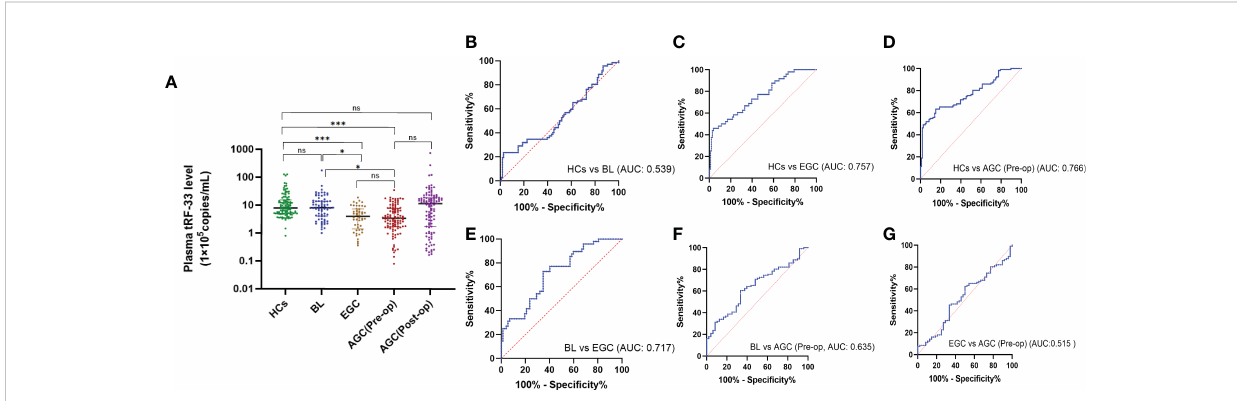
FIGURE 2 Expression levels and diagnostic values of tRF-33-P4R8YP9LON4VDP in different cohorts. (A) The amount of tRF-33 in the plasma showed a gradient change in healthy individuals (HC, n = 106), benign lesion (BL, n = 72), early gastric cancer (EGC, n = 48), pre-operative advanced gastric cancer [AGC (Pre-op), n = 106), and the paired post-operative plasma of advanced gastric cancer patients [AGC (Post-op), n = 106]. * p < 0.05, *** p < 0.001, ns, no signi fi cance. Tamhane ′ s T2 and Dunnett ′ s T3 were used. (B) Receiver operating characteristic (ROC) curve analysis of tRF-33 for healthy individuals and patients with benign lesions. (C) ROC curve analysis of tRF-33 for healthy individuals and early gastric cancer patients. (D) ROC curve analysis of tRF-33 for healthy individuals and advanced gastric cancer patients. (E) ROC curve analysis of tRF-33 for patients with benign lesion and early gastric cancer patients. (F) ROC curve analysis of tRF-33 for patients with benign lesion and advanced gastric cancer patients. (G) ROC curve analysis of tRF-33 for early and advanced gastric cancer patients. AUC, area under ROC